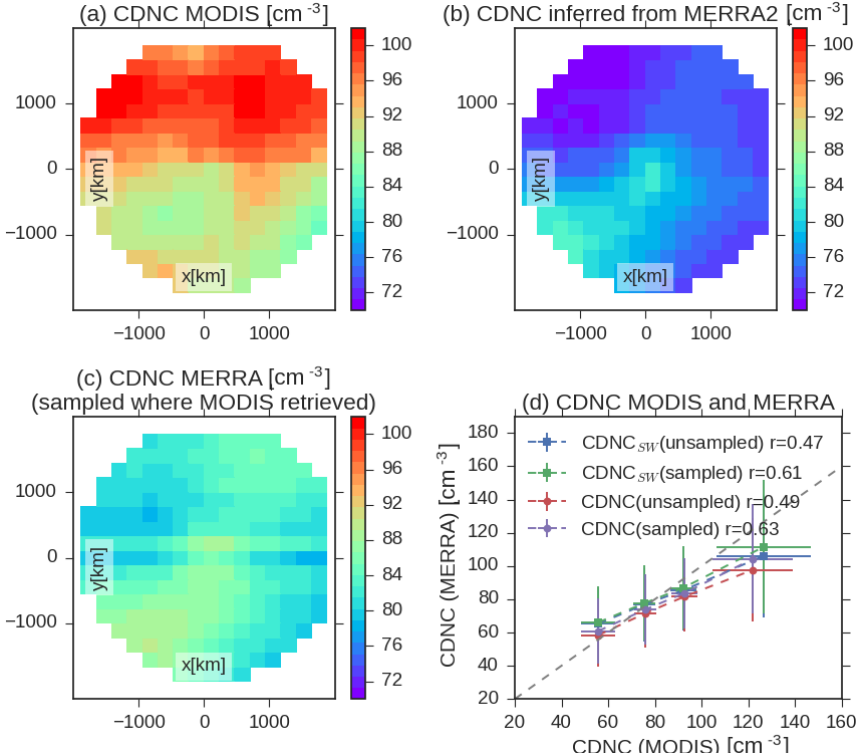
Figure 4. Cyclone composited CDNC (a) retrieved by MODIS, (b) inferred from MERRA2, (c) inferred from MERRA2, but sampled so that failed retrievals from MODIS are not used in calculation of the mean composite from MERRA2. Panel (d) Shows the covariability between MERRA2-inferred and MODIS-retrieved cyclone-mean and southwest quadrant (poleward-oriented) CDNC (CDNC SW ) . The CDNC from MERRA2 is plotted on the y axis and is shown binned by MODIS CDNC. Error bars show 1 standard deviation over each bin. The correlation between the CDNC (and CDNC SW ) from MODIS and from MERRA2 for all cyclones in the observational record is noted in the legend. CDNC (and CDNC SW ) from MERRA2 is calculated when all data are used (unsampled) and when it is sampled to correspond to MODIS.